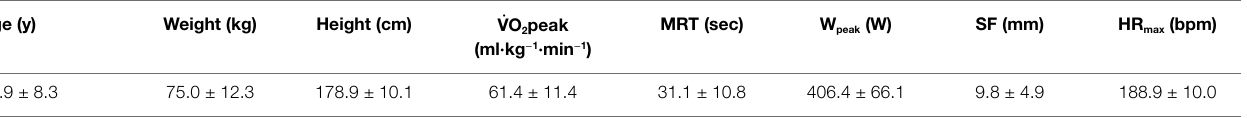
TABLE 1 | Characteristics of study